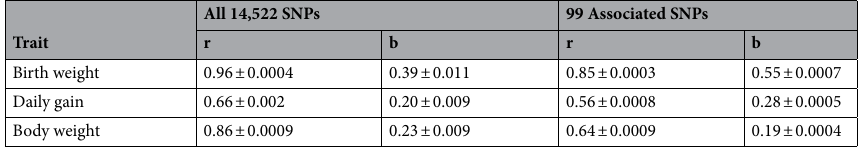
Table 7. The averaged correlation (r) and regression coefficient (b) between the observed values and the GEBVs predicted from two SNPs sets: (1) all 14,522 SNPs and (2) the 99 associated SNPs using BGLR package (BRR